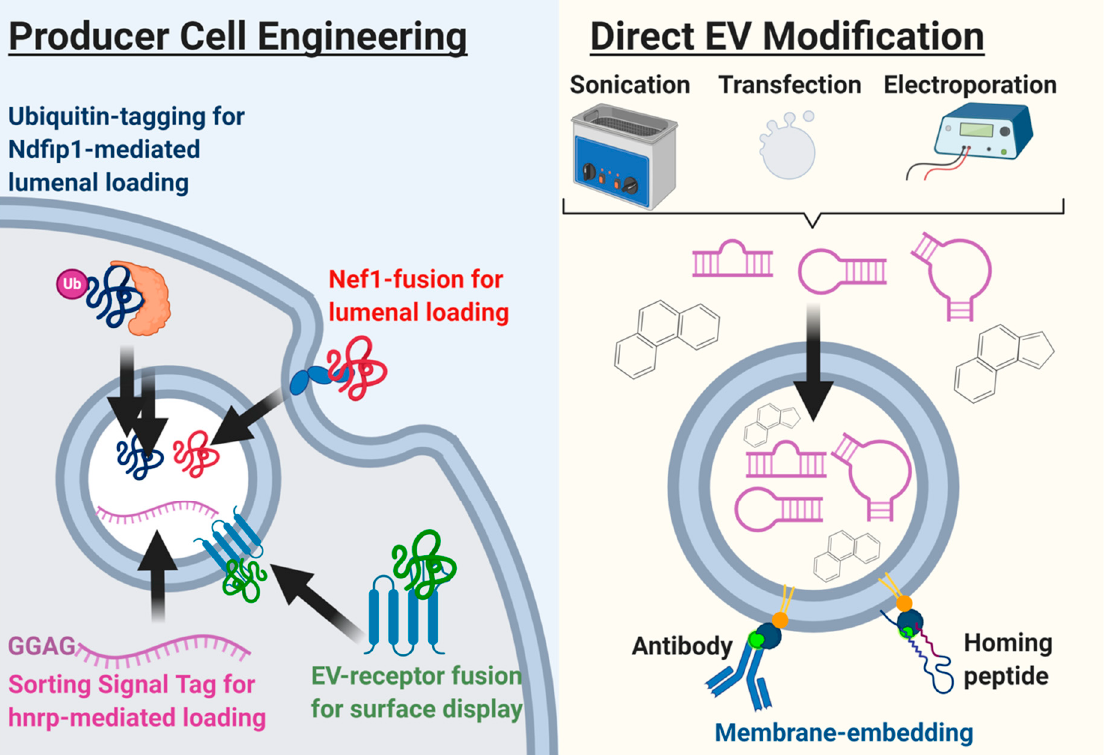
Figure 2. The schematic illustrates the engineering and production of extracellular vesicles.